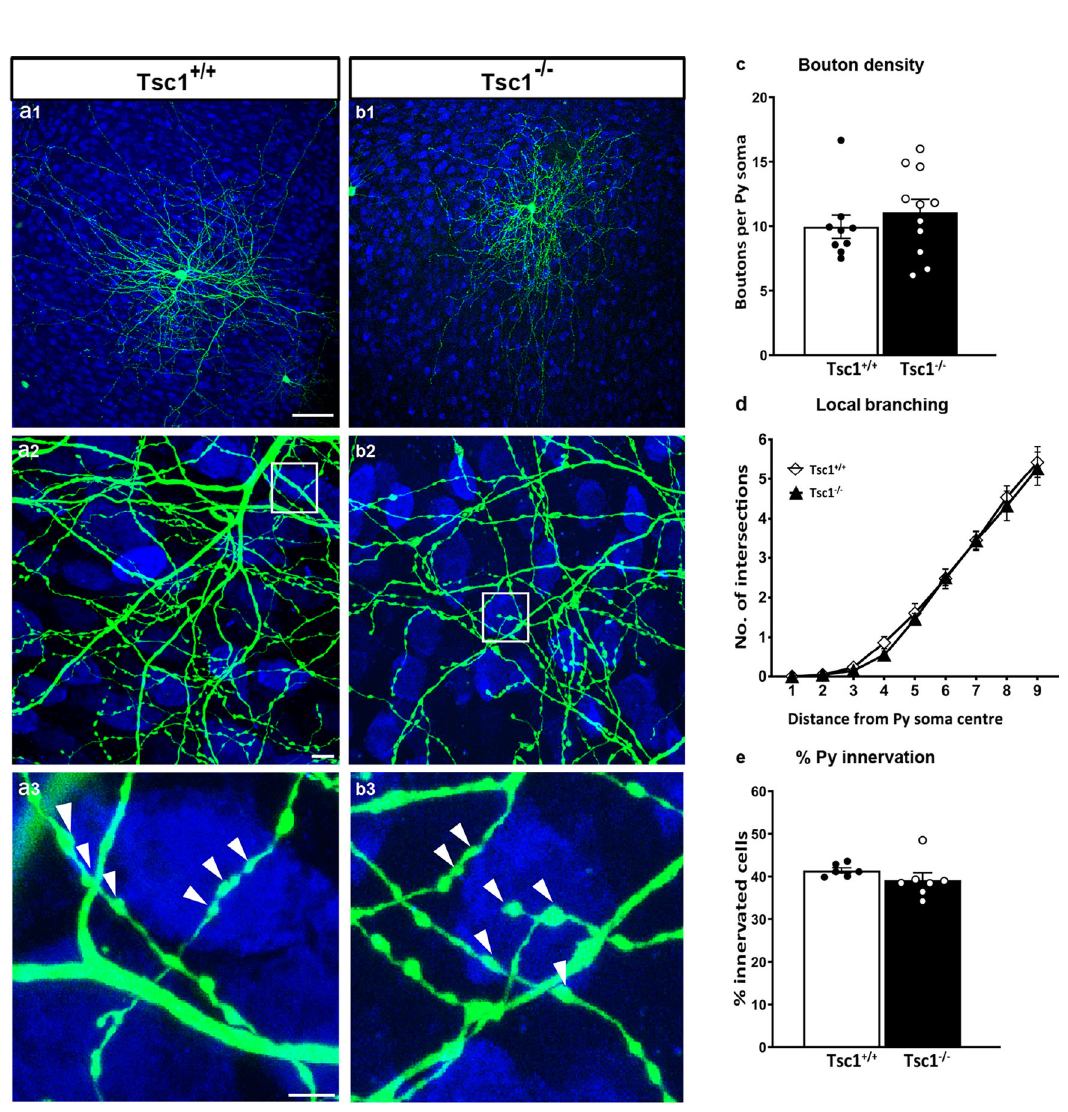
Fig. 7 Late-onset Tsc1 deletion in PV cells does not affect their innervation. a1 EP 34 Tsc1 + / + and b1 Tsc1 − / − PV cells show similar axonal branching ( a2 , b2 ) and perisomatic boutons ( a3 , b3 , arrowheads). c Bouton density (Welch ’ s t -test, p = 0.4091; PV cells: n = 9 Tsc1 + / + , n = 11 Tsc1 − / − ), d local branching (Welch ’ s t -test, p = 0.5789; PV cells: n = 9 Tsc1 + / + , n = 11 Tsc1 − / − ), and e percentage of innervation (Welch ’ s t- test, p = 0.2448; PV cells: n = 6 Tsc1 + / + , n = 7 Tsc1 − / − ) are not signi fi cantly different between the two groups. Scale bars: a1 – b1 , 50 µ m; a2 – b2 , 10 µ m, and a3 – b3 , 5 µ m. Data in represent mean ± SEM. Source data are provided as a Source Data fi